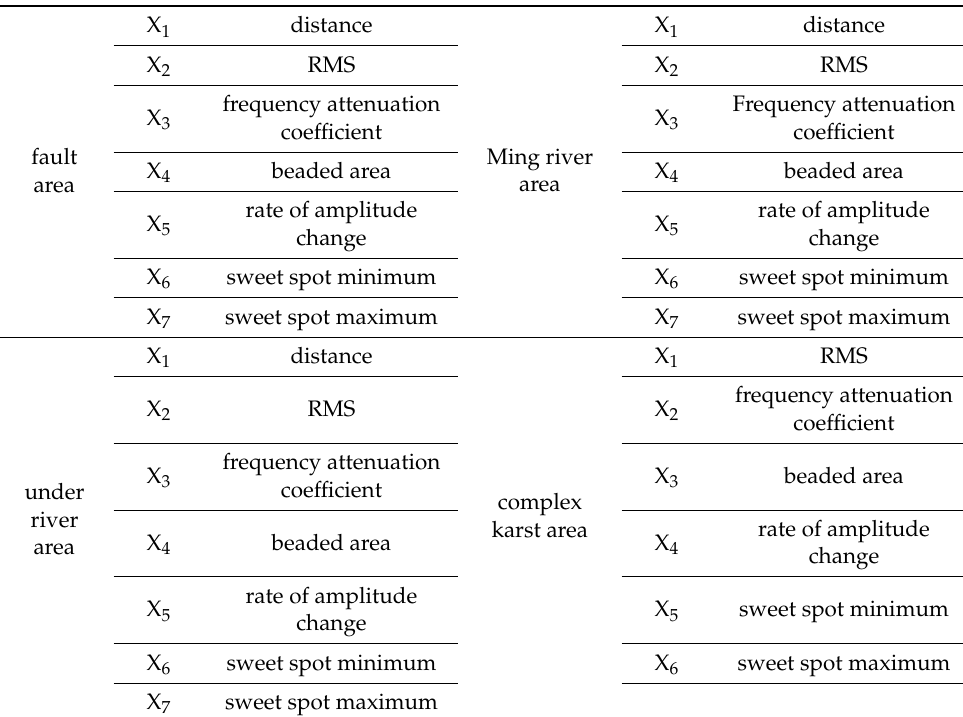
Table 2. Seismic attribute corresponding